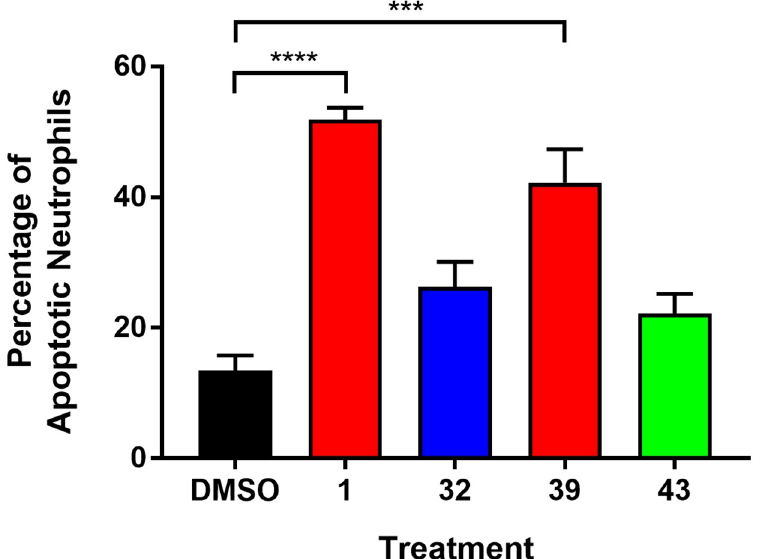
Fig 11. Effects of active compounds on neutrophil apoptosis. Freshly isolated human neutrophils were incubated for 6 hours at 37 ᵒ C with the following compound treatments: DMSO, and compounds 1 , 32 , 39 and 43 (25 μ M), with DMSO used as a vehicle control. Percentage neutrophil apoptosis for each condition was quantified from duplicate cytospins. Cells were classified as either apoptotic or non-apoptotic based on the morphology of their nuclei. Data shown as mean ± SEM; n = 4000 neutrophils from 4 independent experiments. ��� P < 0.001, ���� P < 0.0001, in comparison to the DMSO control (one-way ANOVA with Dunnett’s multiple comparison post-test).